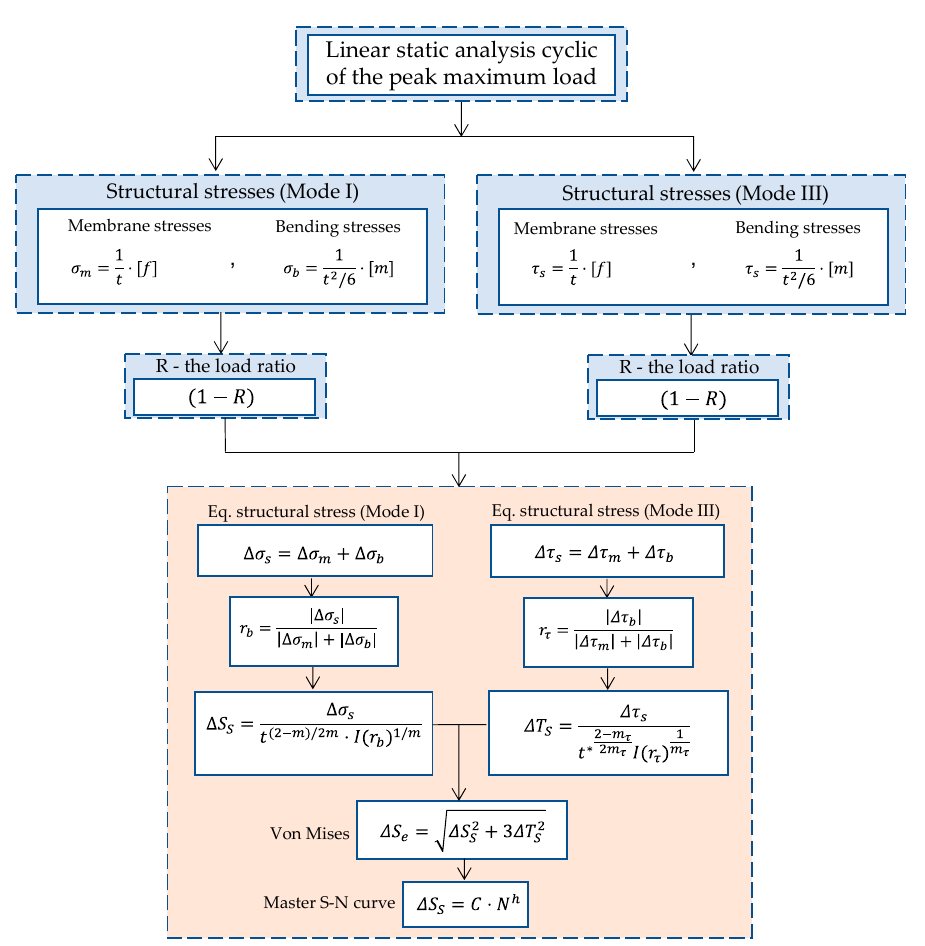
Figure 4. Flowchart of multiaxial fatigue analysis (mixed-mode I + III) using the master S-N curve method.